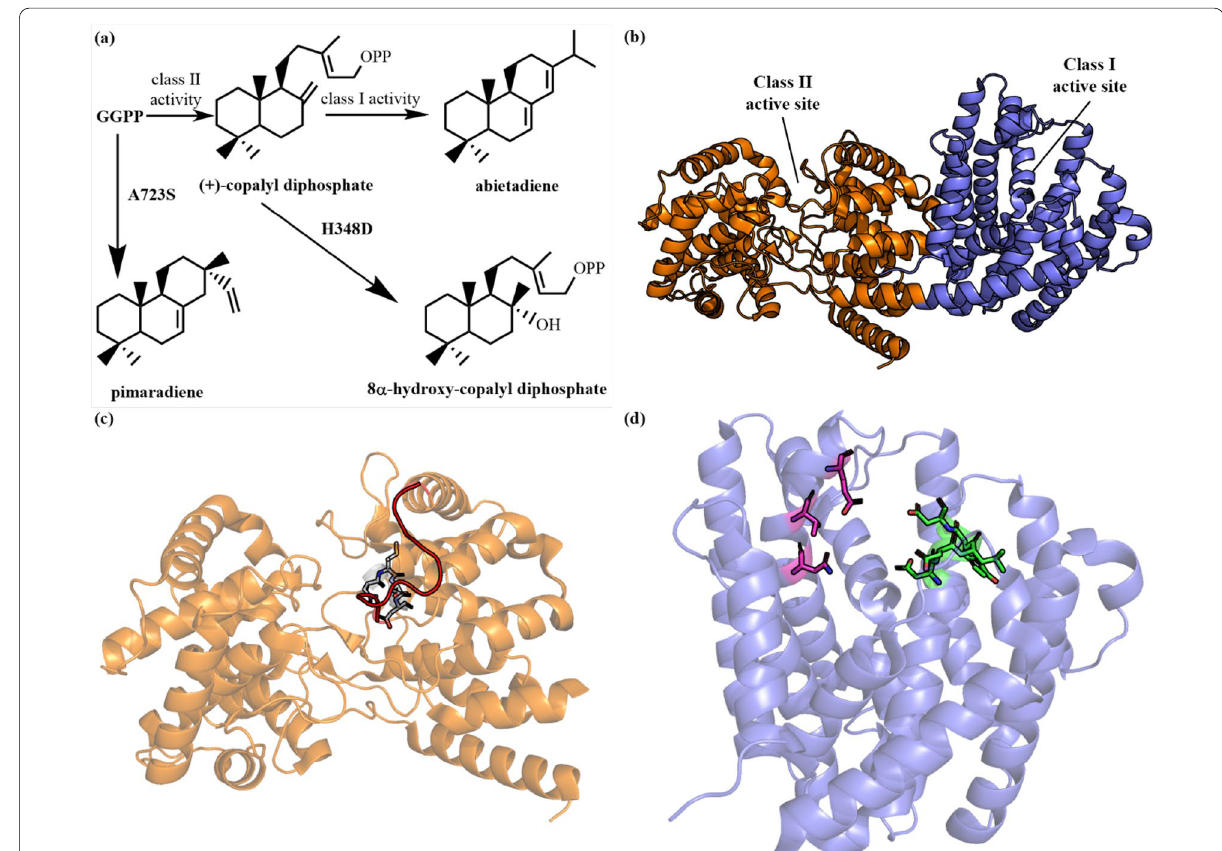
Fig. 20 a Products of Ag AS and its mutants. b Crystal structure of Ag AS (PDB ID: 3S9V ). c Class II active site of Ag AS. The motif of class II terpene cyclase (D 402 XDD) are shown in sticks (white). The loop 482–492 is in red. d Class I active site of Ag AS. The metal binding motifs of class I terpene cyclase: D 621 DXXD, green; N 765 TE,